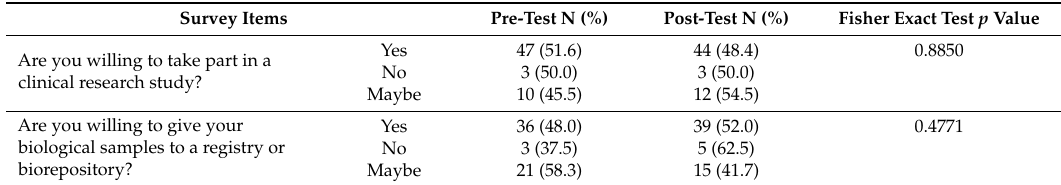
Table 3. Effects of educational session: Results of Fisher Exact Test ( n = 60). Survey Items